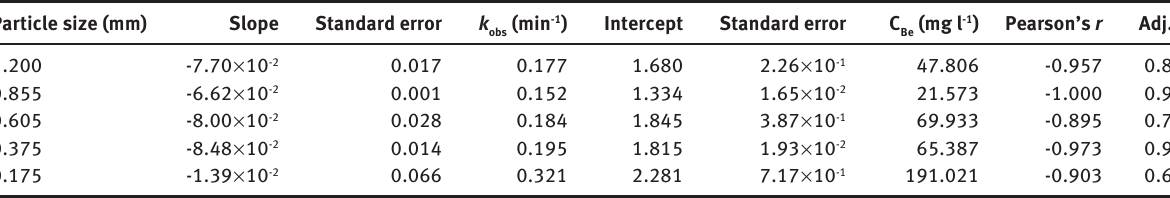
Table 3: First-order kinetics model for the isothermal green solid-liquid extraction of andrographolide at 80 ° C from Andrographis panicu- lata (AP) for different particle sizes and a solid-liquid ratio of 1:50 (g ml -1 ).